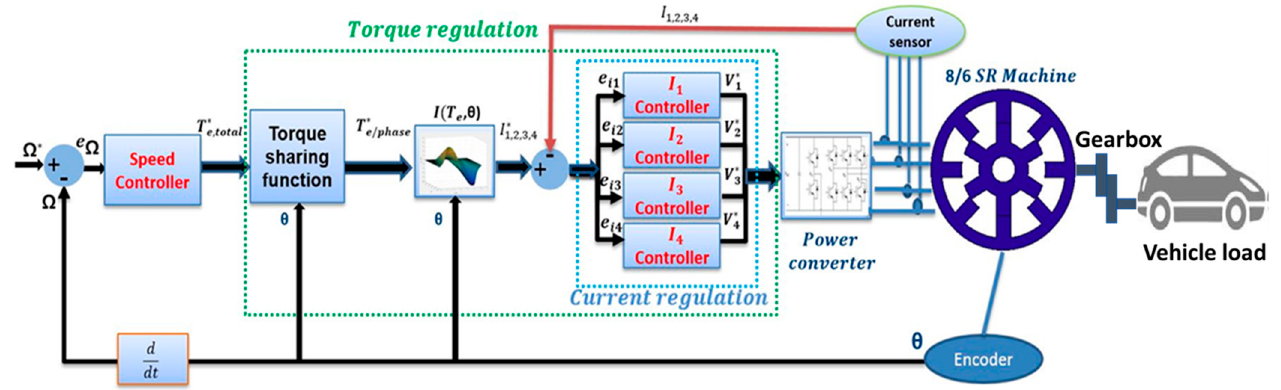
Figure 4. Block diagram of the control strategy.